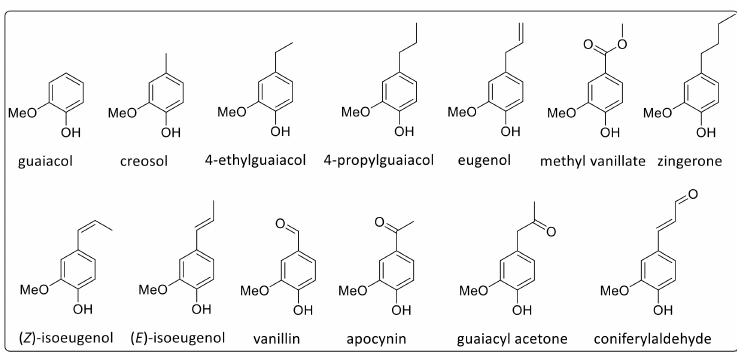
Figure 11. Detected Py-GC/MS fragments attributed to the G-unit.